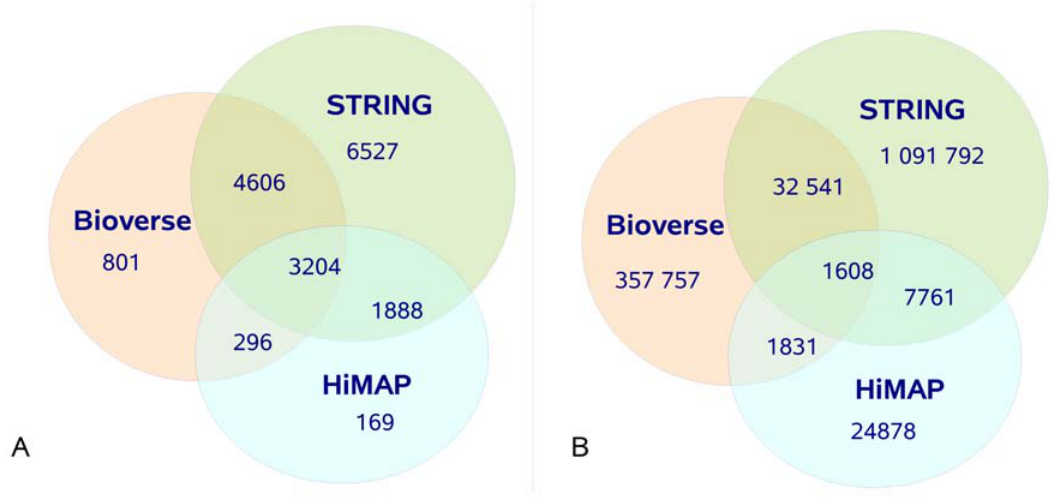
Figure 1. Venn diagram of the overlap between Bioverse, HiMAP and STRING. (A) Overlap between genes. Approximately 57% of the genes are common to at least two databases. (B) Overlap between interactions. Only 2.8% of the interactions are reported in more than one database.